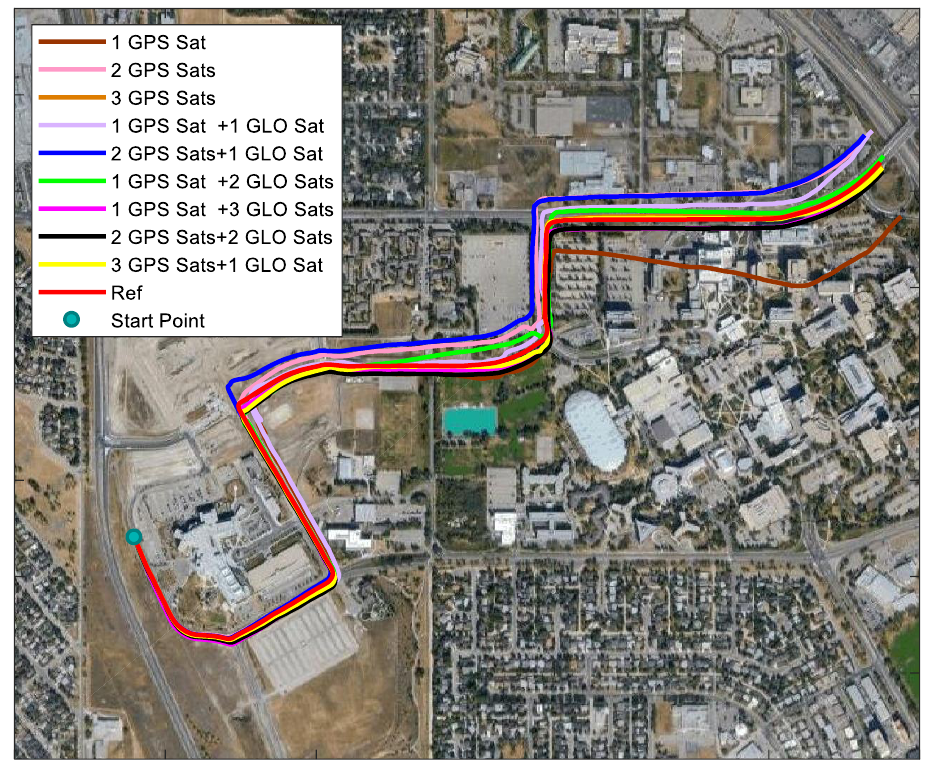
Figure 8. Trajectories of using different GPS and GLONASS satellites.